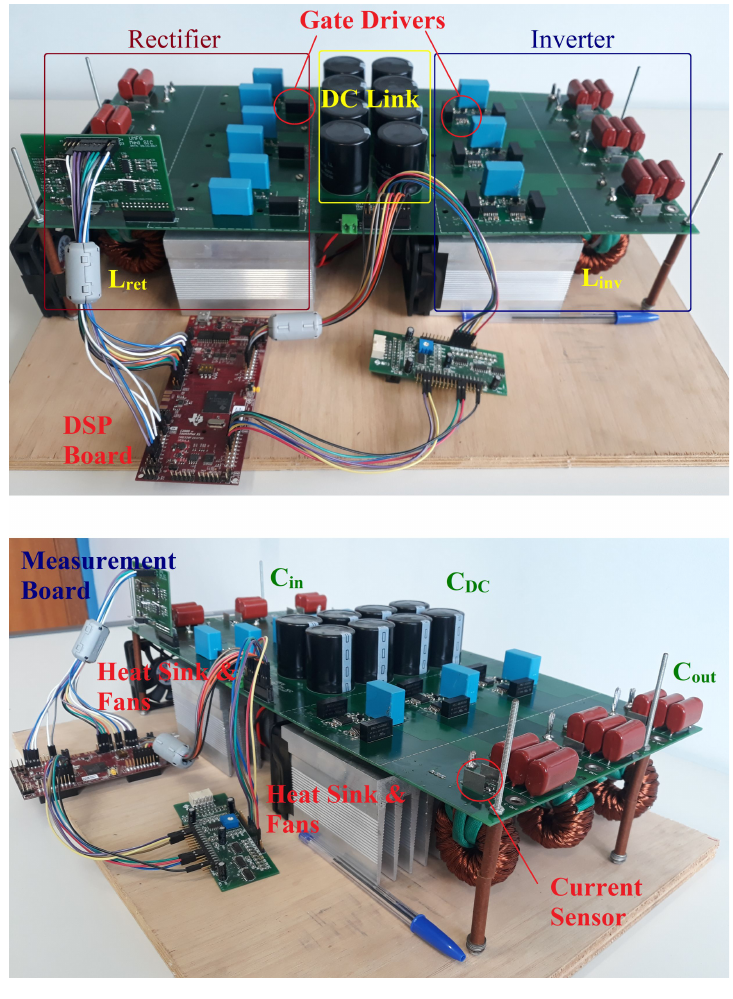
Figure 9. Designed prototype.